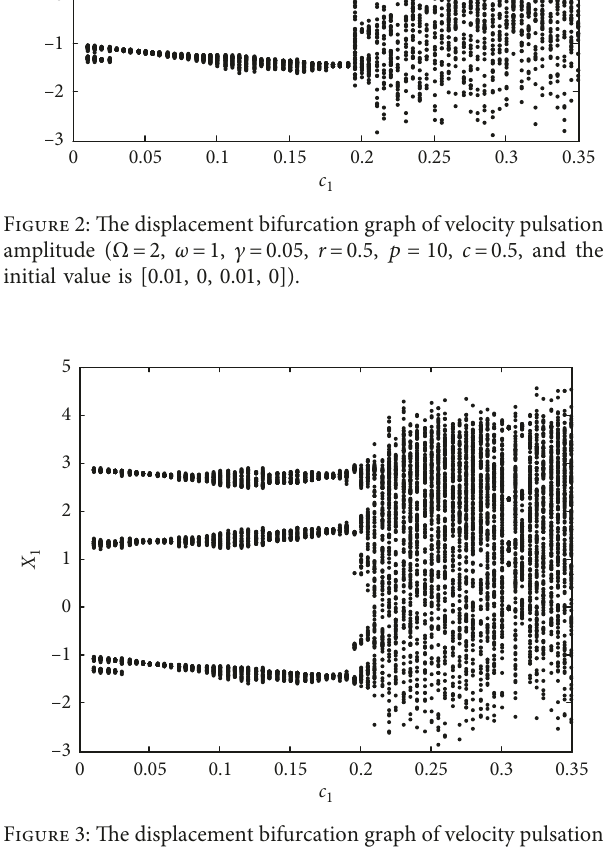
Figure 8 that the bifurcation diagram of dimensionless dis- placement and aspect ratio when the frequency of di- mensionless velocity Ω � 2, dimensionless velocity pulsation � 0.05, dimensionless excitation frequency ω � 1, amplitude c 1 dimensionless damping constant c � 0.05, dimensionless speed c � 0.5, dimensionless external excitation amplitude p � 10, and the initial values are [0.01, 0, 0.01, 0], the range of variation of aspect ratio is 0 . 2 ≤ r ≤ 2. As it is shown in Figure 8, when 0 . 305 < r < 0 . 355 and 0 . 395 < r ≤ 2, the bi- furcation diagram has fewer points, and it is specified that the membrane is in stable motion in these regions; thus the membrane is in steady working range. When 0 . 2 ≤ r ≤ 0 . 305, 0 . 355 ≤ r ≤ 0 . 395, the bifurcation figure has the dense points,